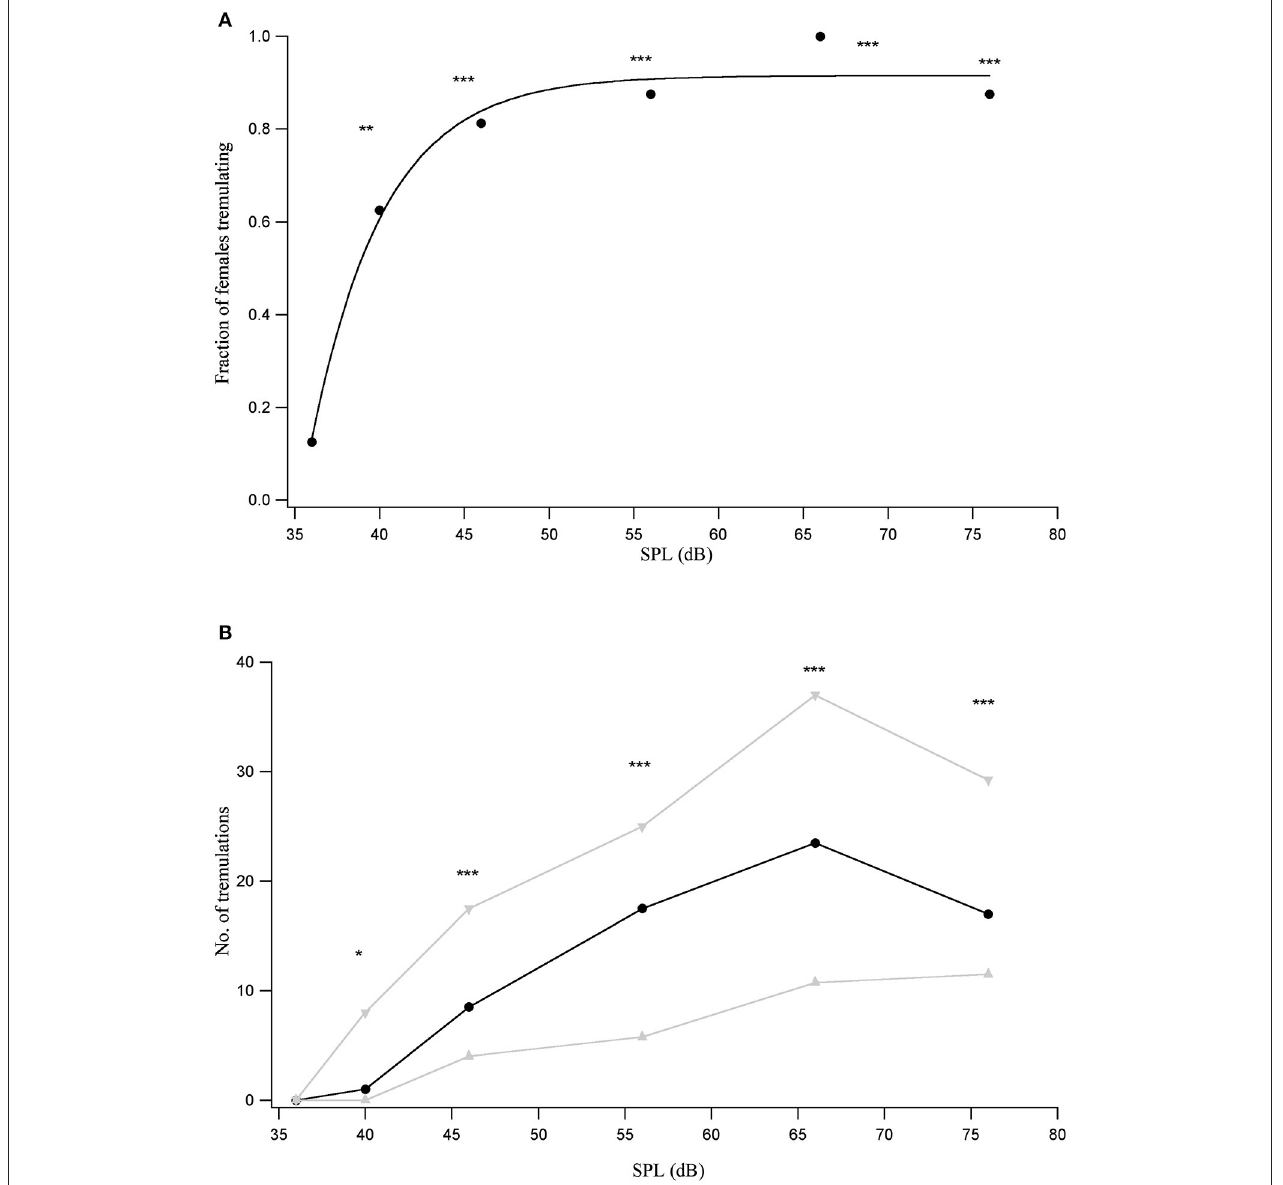
FIGURE 2 | (A) Proportion of animals that tremulate in response to the conspecific call played back at different SPLs ( n = 16). ** p < 0.01, *** p < 0.001 for comparisons of response at a given SPL with the response to silent controls. (B) Median number of tremulation events (black trace) observed across animals in the first minute following the onset of the conspecific male acoustic call, played back at different SPLs, with the interquartile range indicated in gray. * p < 0.05, *** p < 0.001 for pairwise comparisons with the response to a silent control.